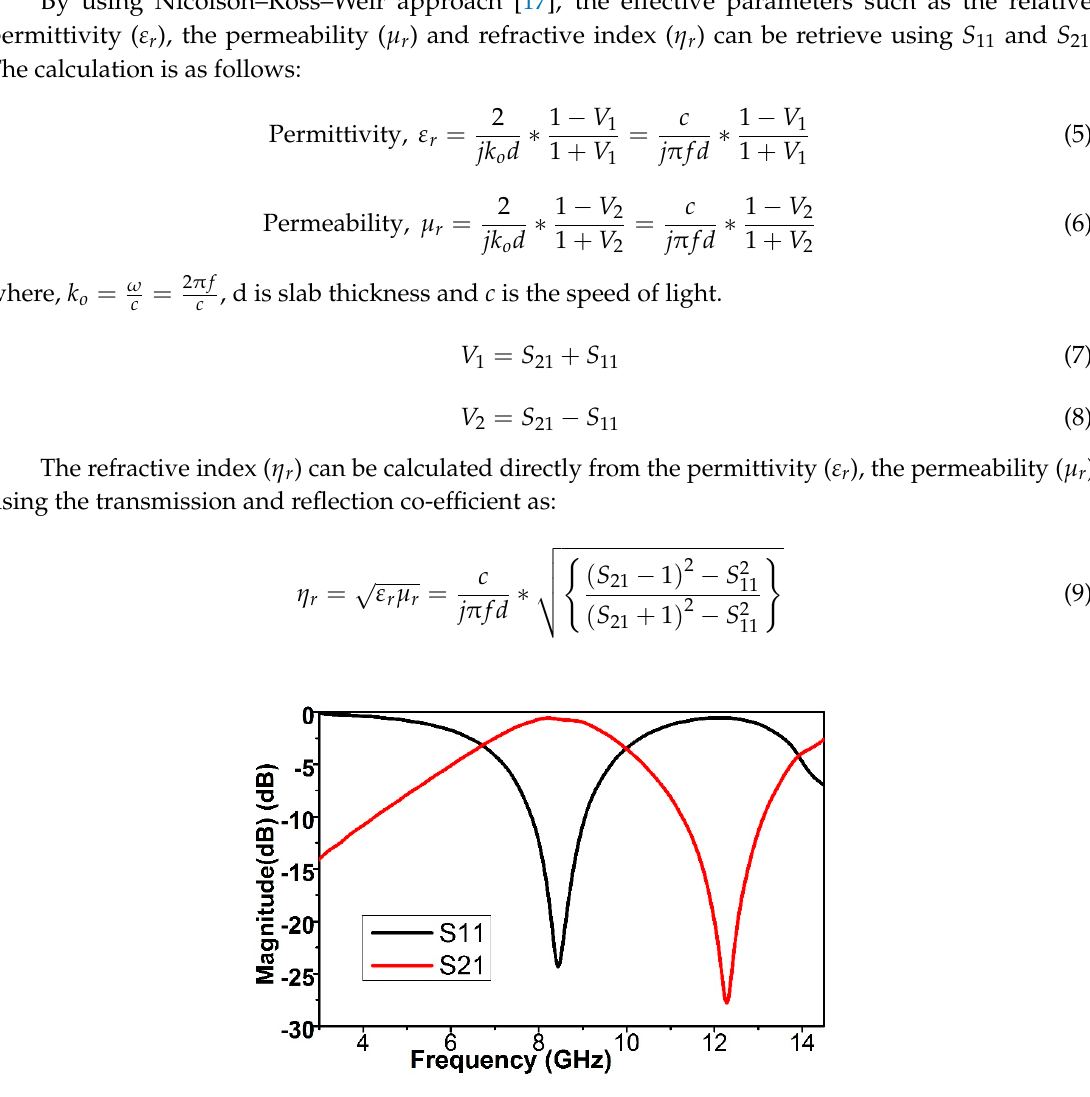
Figure 2. Magnitude of S-parameters (reflection co-efficient S 11 and transmission co-efficient S 21 ) of proposed unit cell.